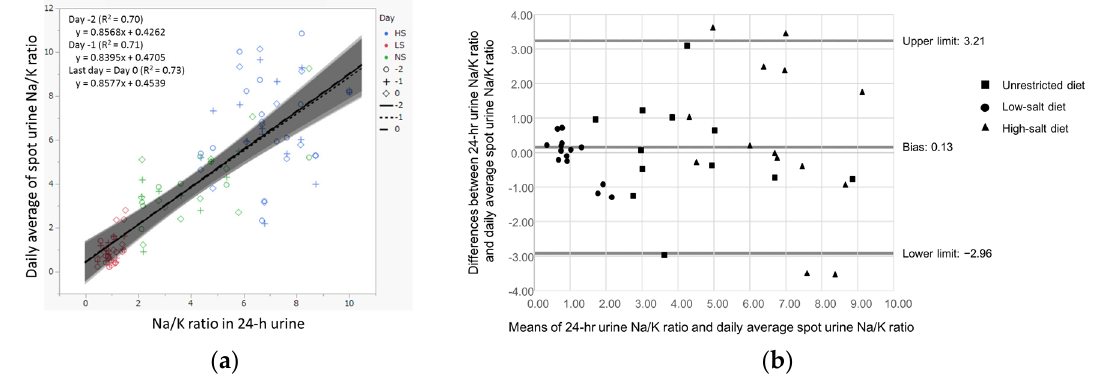
Figure 2. Correlation and agreement analyses between individual daily means of the spot urine Na/K ratio and 24-h urine Na/K ratio: ( a ) Spearman’s correlation between the 24-h urine Na/K ratio during the last day of each diet period and individual daily means of the spot urine Na/K ratio of the last three days of each diet period. Data points from unrestricted (NS), low-salt (LS), and high-salt (HS) diet periods are shown in green, blue, and red, respectively. The regression lines calculated for the last day (0), the day before ( − 1), and two days before the last day ( − 2) are shown with 95% confidence interval in gray areas. ( b ) Bland-Altman plot of the 24-h urine Na/K ratio and daily means of the spot urine Na/K ratio on the last day of each diet period.